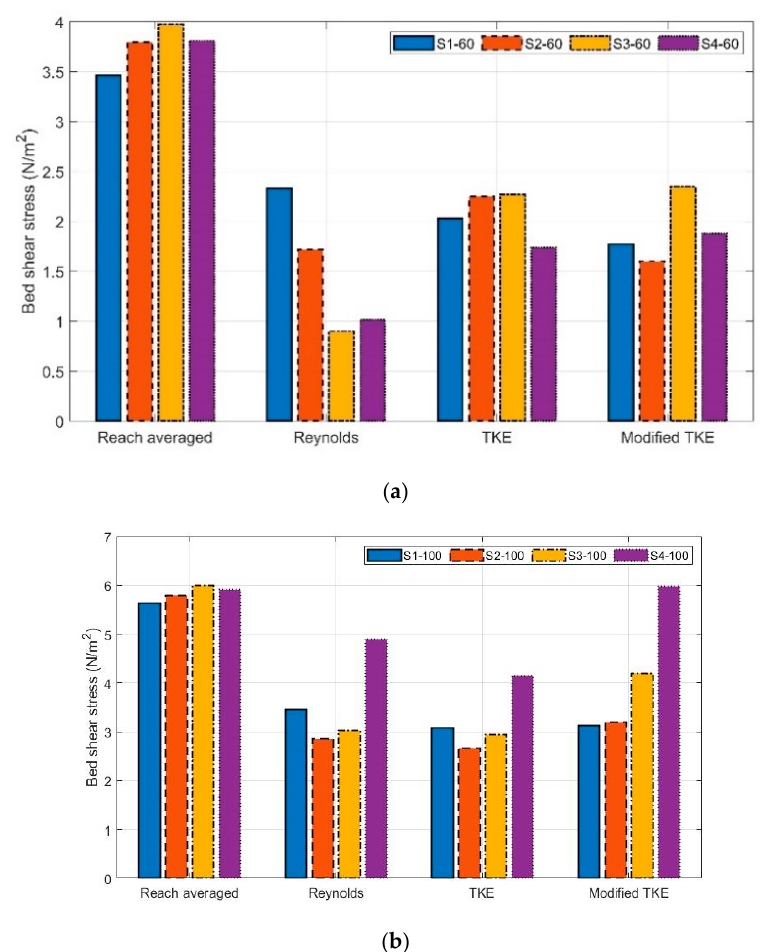
Figure 3. Averaged bed shear stress resulted from different calculation methods for different boulder spacing at ( a ) 60 L/s flow rate, ( b ) 100 L/s flow rate.